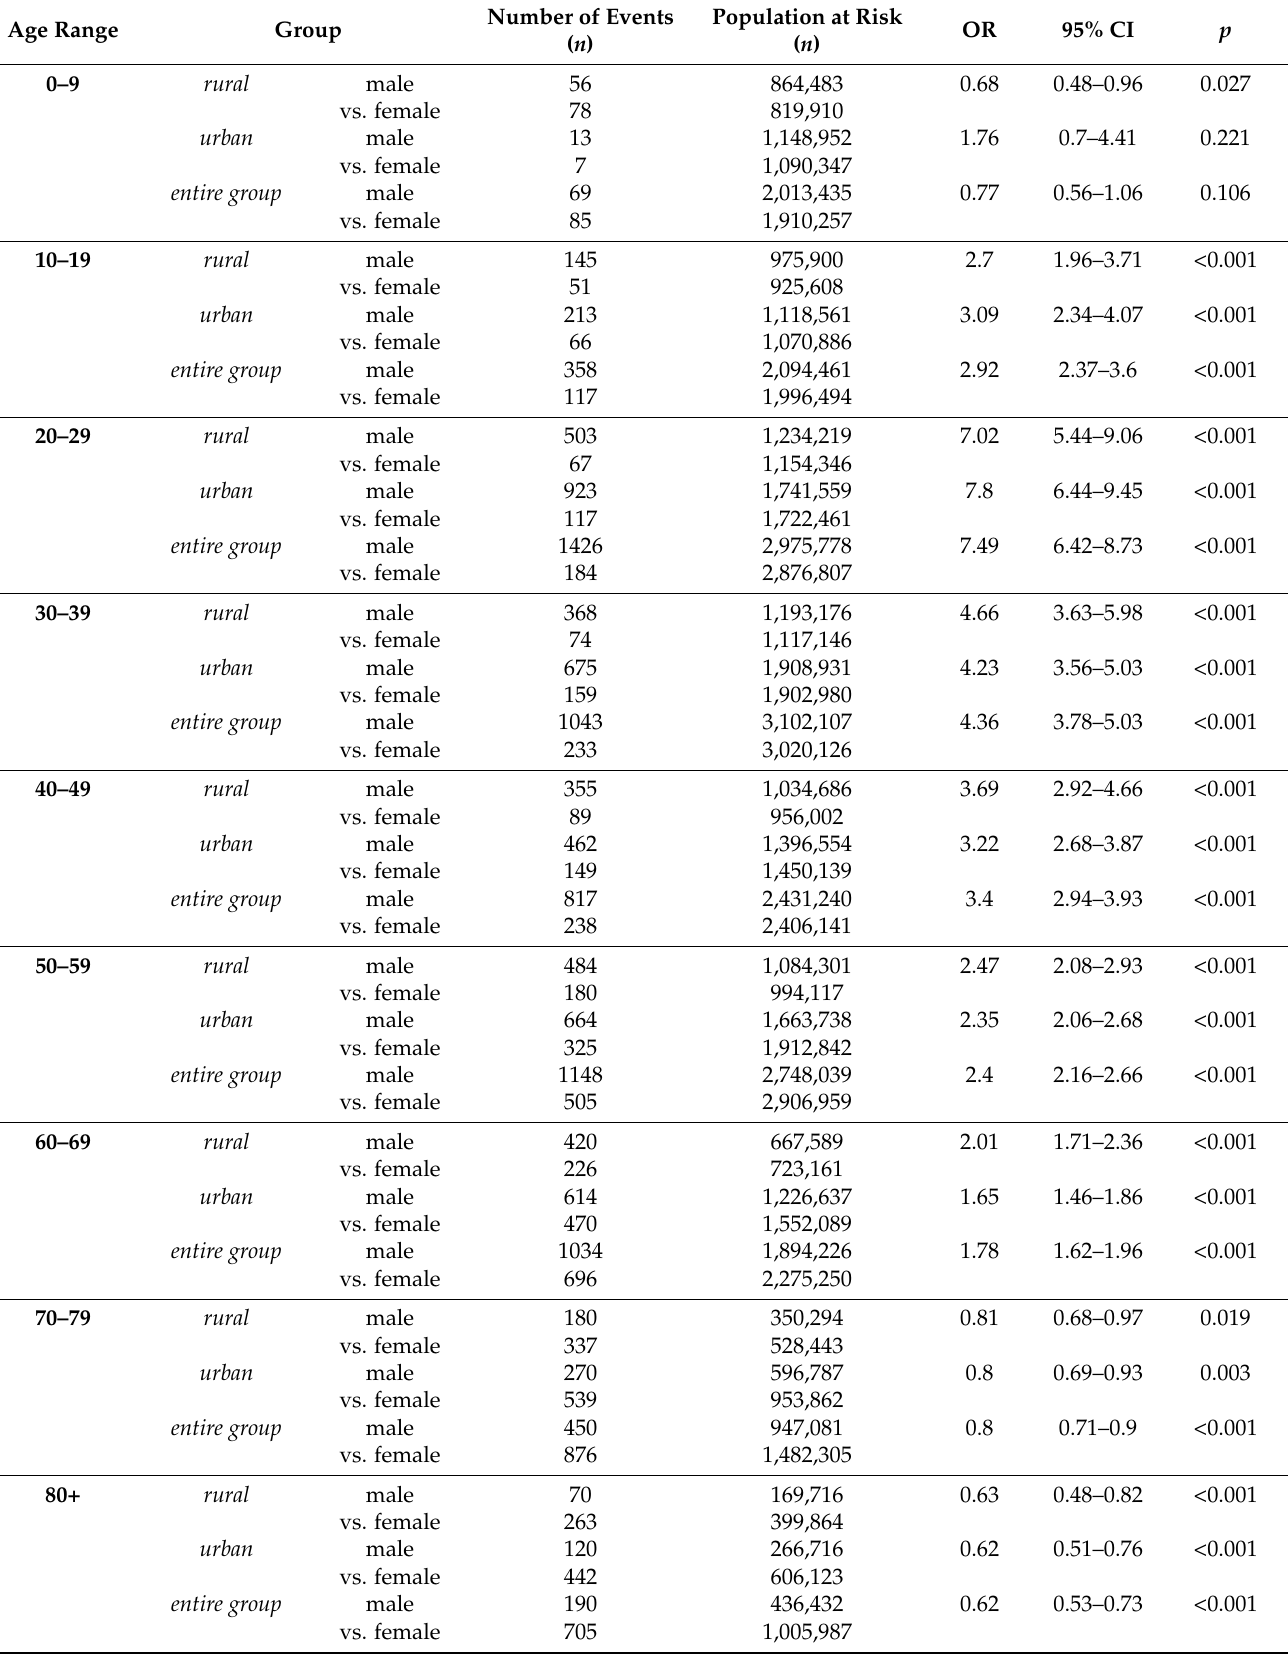
Table 4. Comparison of shoulder dislocation risk based on sex and place of